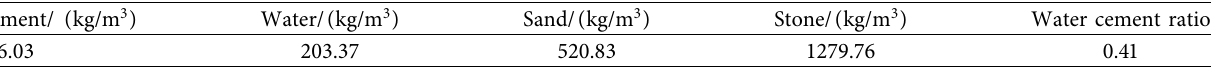
Figure 1: Article content process. Table 1: The concrete mix